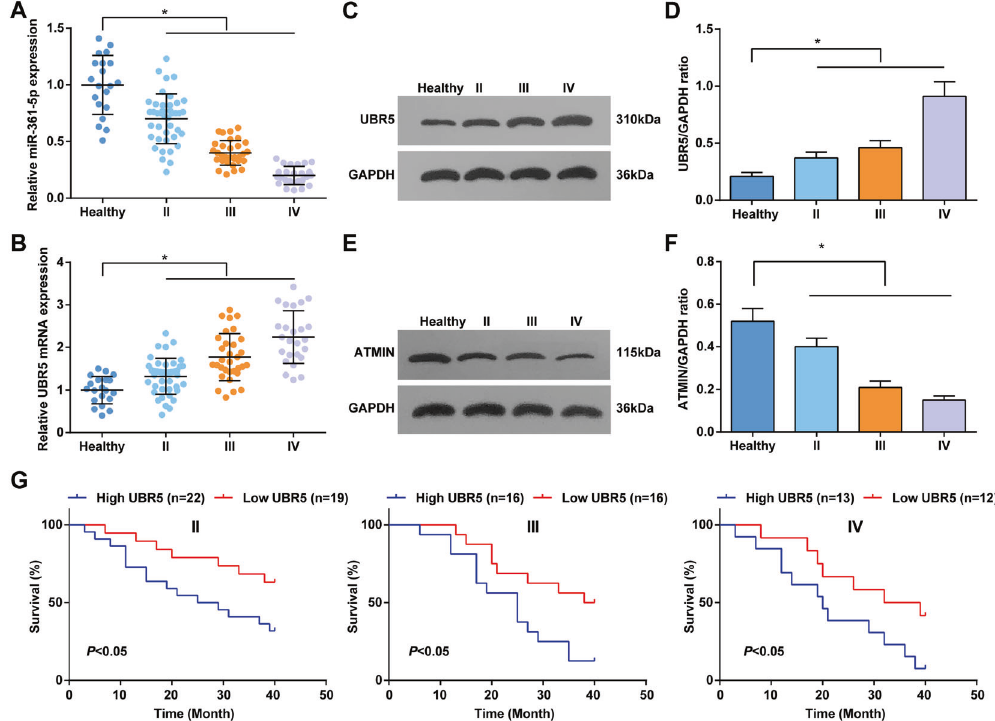
Fig. 1 miR-361-5p and ATMIN are upregulated and UBR5 is downregulated in gliomas. A RT-qPCR tested miR-361-5p expression in brain tissues of healthy controls and patients with gliomas at different stages. B RT-qPCR tested UBR5 mRNA expression of UBR5 in brain tissues of healthy controls and patients with gliomas at different stages. C , D Western blot tested UBR5 protein expression in brain tissues of healthy controls and patients with gliomas at different stages. E , F Western blot tested ATMIN protein expression in brain tissues of healthy controls and patients with gliomas at different stages. G Kaplan – Meier survival curve analyzed the relationship between UBR5 expression and the prognosis of patients with gliomas at different stages, univariate analysis was performed by Log-rank test; the data were all measurement data, in the form of mean ± standard deviation; * P < 0.05 indicated the relationship between patients with gliomas at different